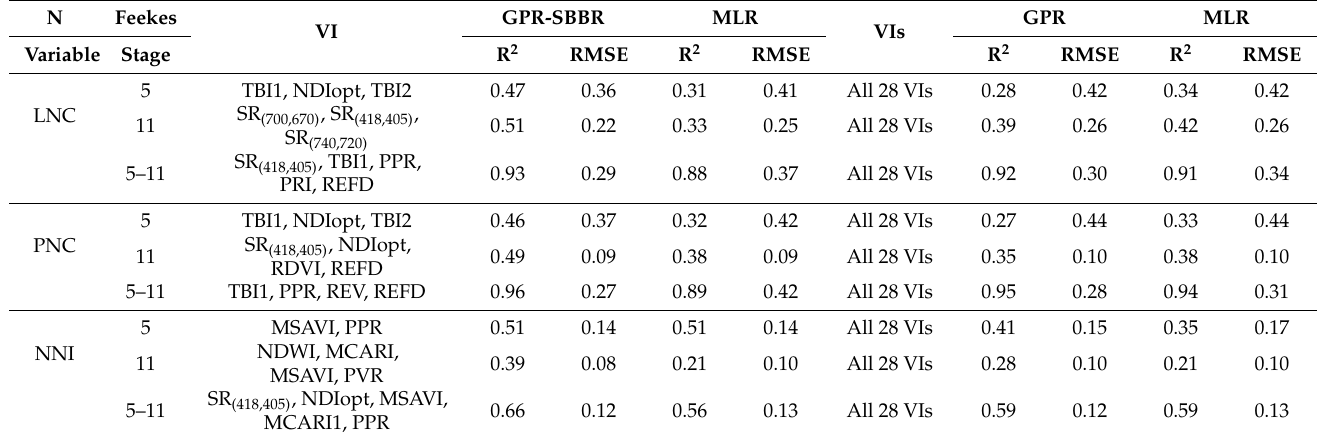
Table 9. Cross-validation results for N estimation through GPR and MLR methods based on ASD VIs.